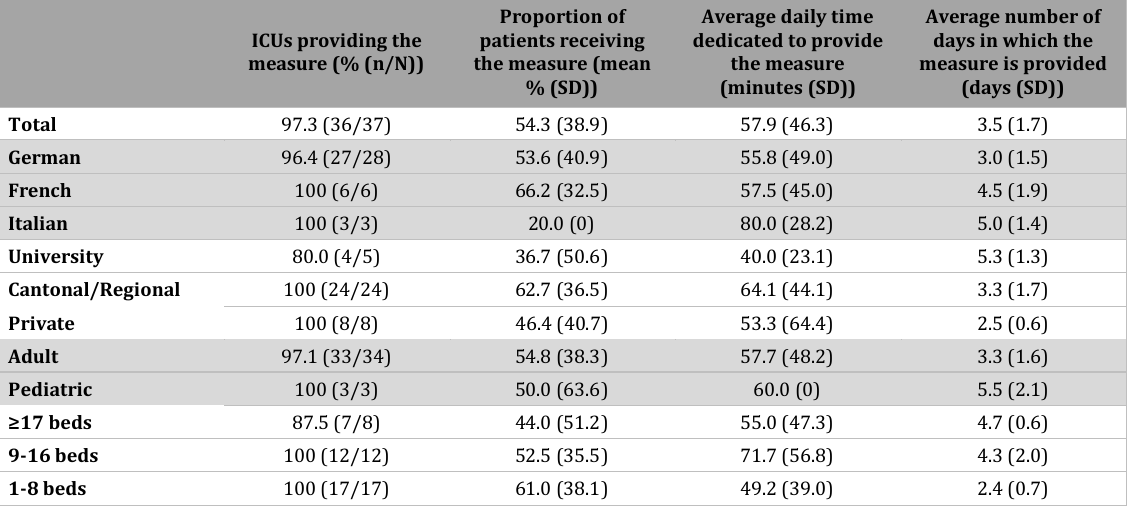
Table S7. Passive chair position in bed, tilt table